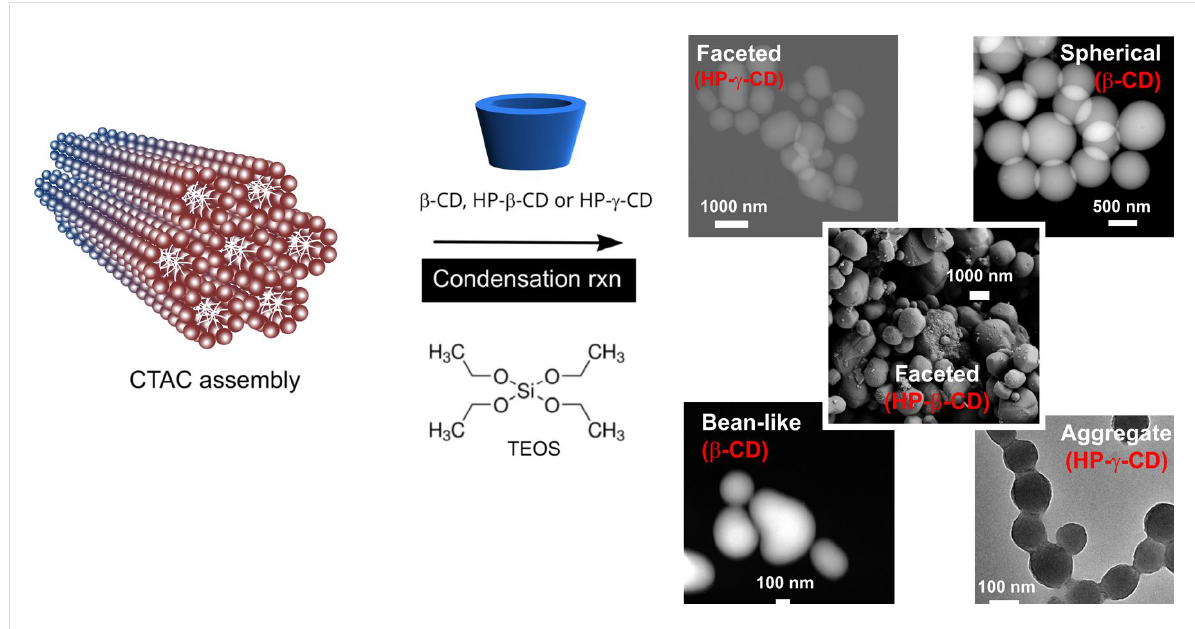
Figure 1: Synthesis scheme, electron microscopy images (S-TEM, TEM and SEM) of MSNs of various shapes that were synthesized in the presence of different CD types ( β -CD, HP- β -CD and HP- γ